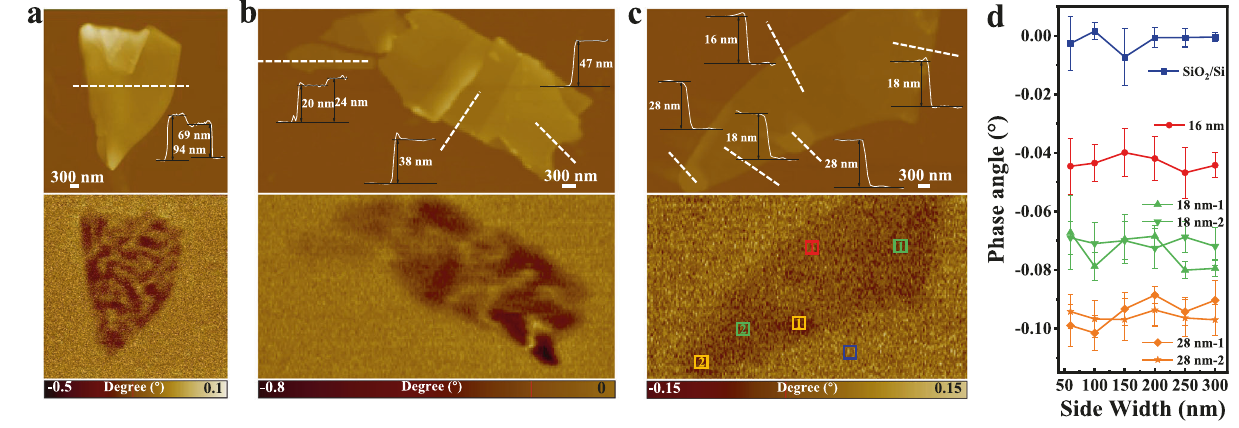
Fig. 4 | Room-temperature direct magnetic domain imaging without external magnetic fi eld in single-sheet Fe 3 GaTe 2 nanosheets by MFM. a – c AFM topo- graphy (top) and corresponding in situ MFM images (bottom) of Fe 3 GaTe 2